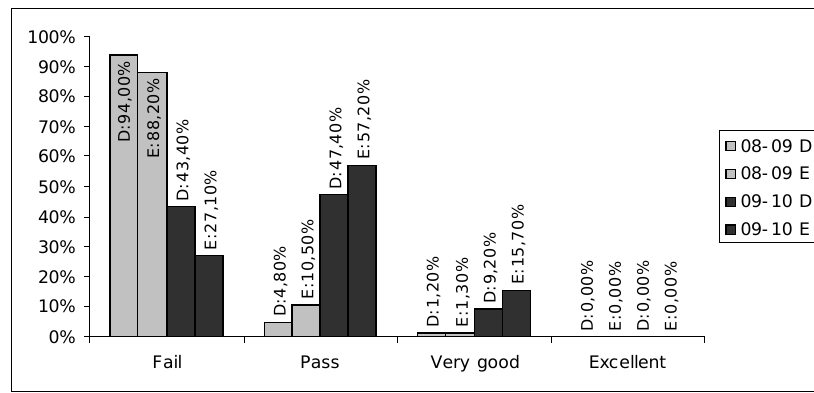
Figure 3. “Comparison of the results of the final theory exam of BLOCK II (groups D and E) for academic years 08-09 and 09-10”. Source: